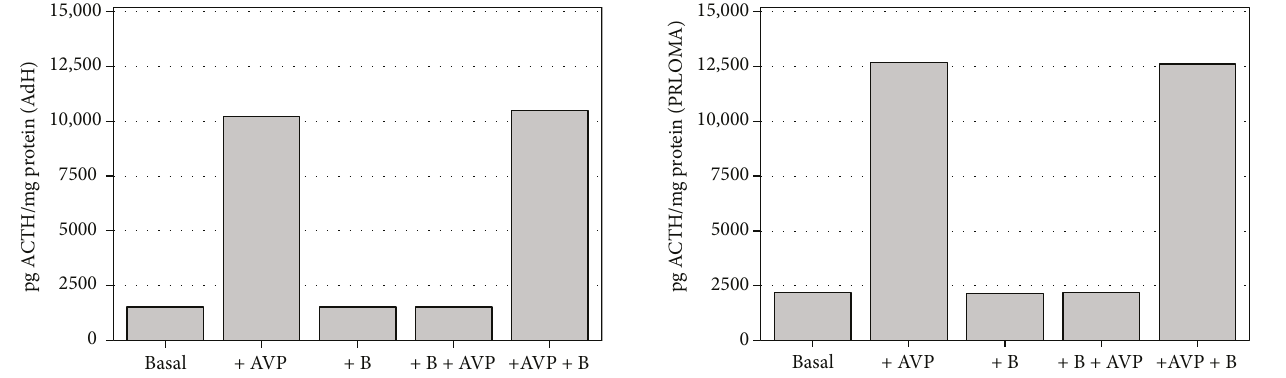
Figure 1: Functional assay for ACTH release in normal rat adenohypophysis cultures, in vitro ( n = 8 – 12 in each group); mean level ± SEM (pg ACTH/mg protein): AVP signi fi cantly increases ( p < 0 001 ), whereas corticosterone alone does not alter ACTH release when compared to control; preincubation with +B inhibited AVP activation (basal: control; AVP: 8-arginine vasopressin; B: corticosterone).